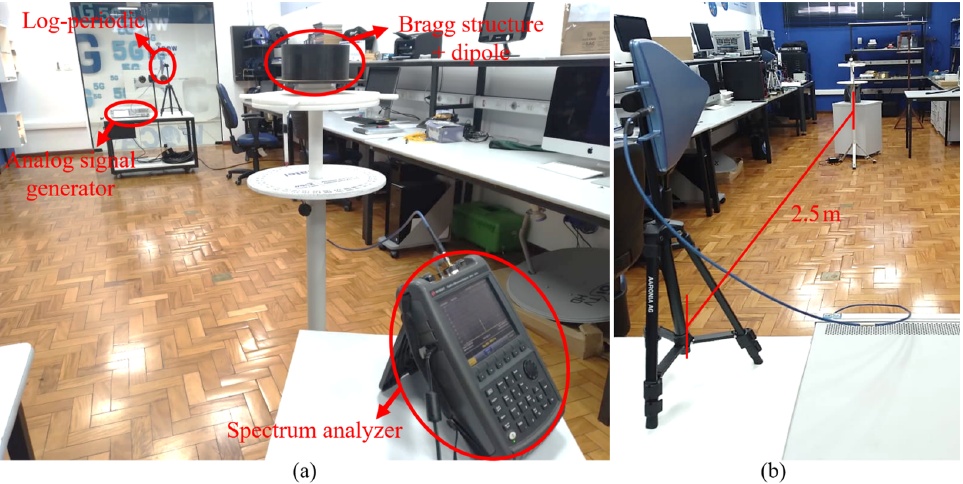
Figure 8. Pictures of the experimental setup taken ( a ) from the Bragg reflector to the antenna and ( b ) from the antenna to the Bragg